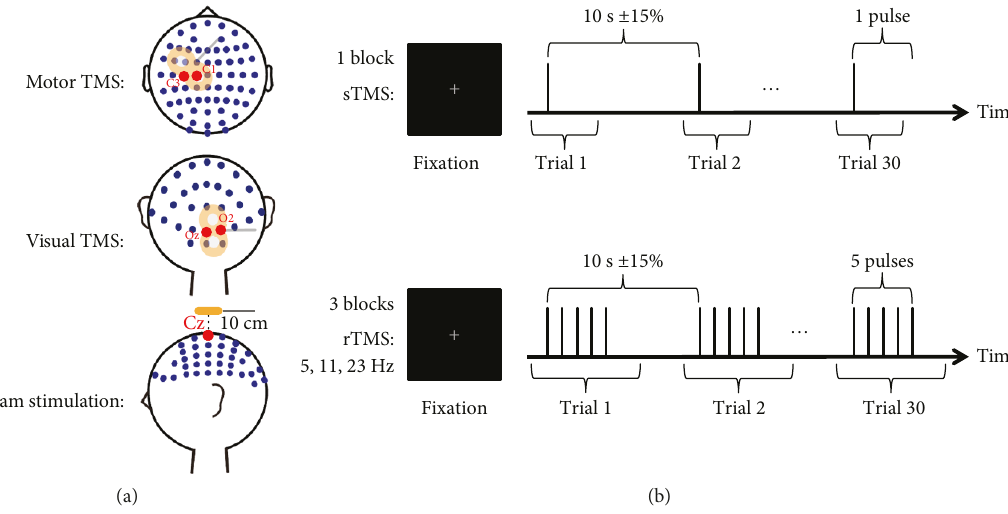
Figure 1: Experimental design. (a) The EEG electrode layout used in the present study is displayed along with the di ff erent stimulation sites. In separate sessions, TMS was applied over the left motor cortex ( fi rst row), over the right visual cortex (second row), and as sham stimulation 10cm above the vertex of the head (third row). (b) Each session contained four blocks of 30 trials each, in which we performed sTMS ( fi rst row) as well as 5Hz, 11Hz, and 23Hz rTMS (second row). During rTMS trials, stimulation was delivered in trains of fi ve consecutive